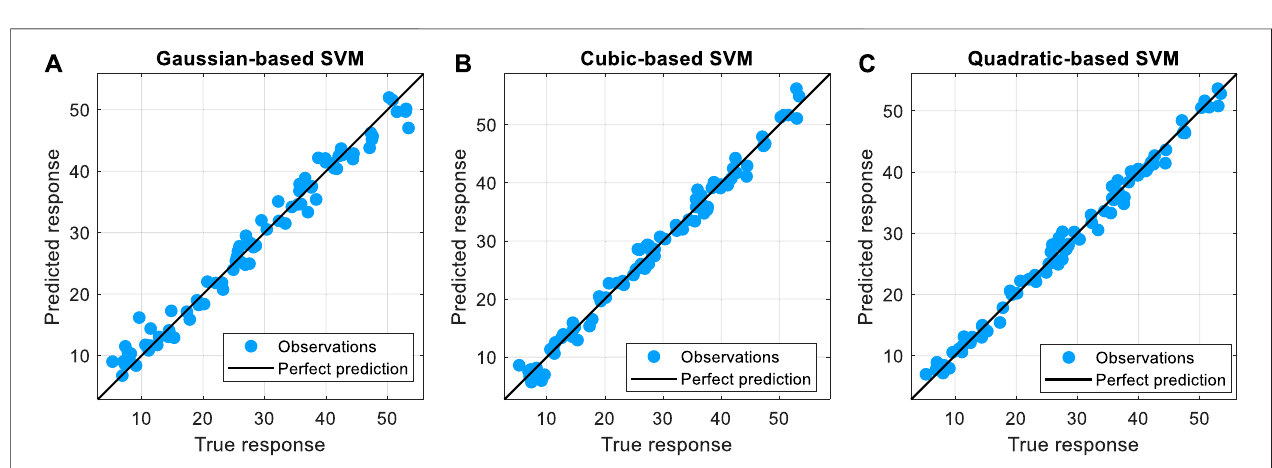
FIGURE 4 | Predicted versus actual plots using different kernel-based SVMs: (A) Gaussian kernel, (B) quadratic kernel, and (C) cubic kernel.